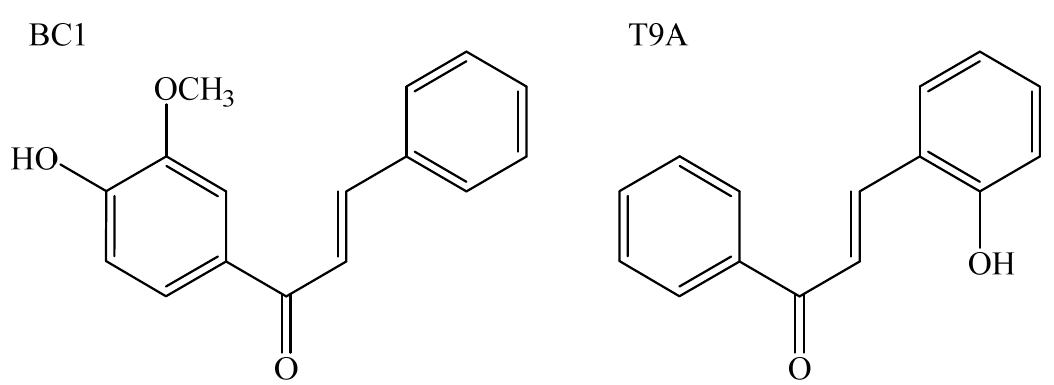
Figure 1. Structures of the compounds used in this study.